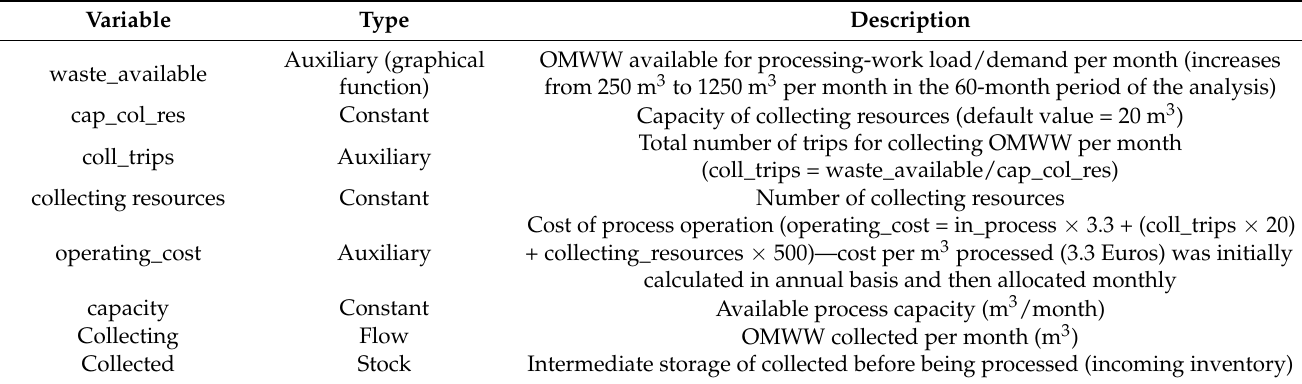
Figure 5. The system dynamics model of the techno-economic analysis. Table 5. System dynamics model variables and their explanation.